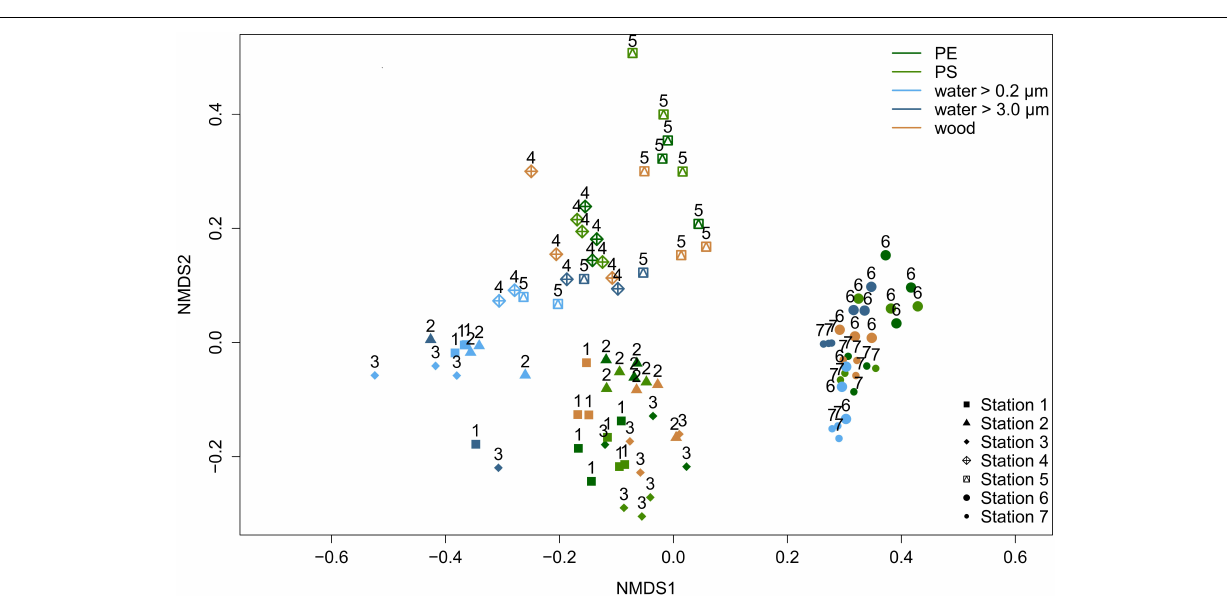
FIGURE 2 | Non-metric multidimensional scaling (NMDS) ordination visualizing Bray-Curtis similarities of eukaryotic communities among individual samples (stress value = 0.15). With increasing similarity, the points have a closer proximity. Colors represent different substrate types. Symbols and numbers indicate different